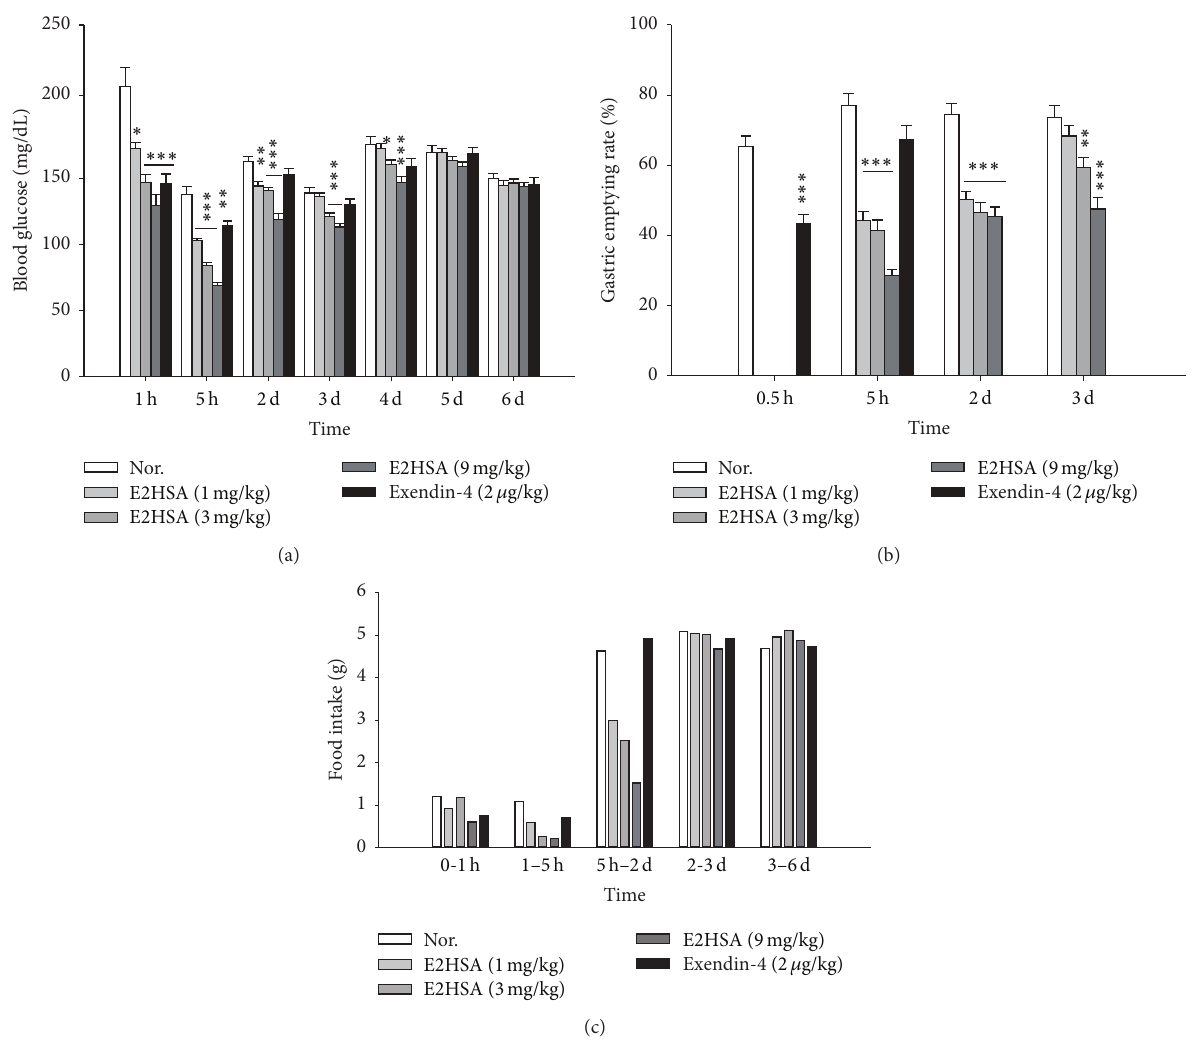
Figure 3: Long-acting effects of E2HSA on nonfasting blood glucose levels (a), gastric emptying (b), and food intake per mouse (c) in normal ICR mice injected with a single dose subcutaneously. Food intake was measured per cage and expressed as food intake per mouse within the indicated time period. Nor., normal ICR mice administered saline. Data are expressed as mean ± S.E.M ( 𝑛 = 10 ). ∗ 𝑃 < 0.05 , ∗∗ 𝑃 < 0.01 , and ∗∗∗ 𝑃 < 0.001 versus